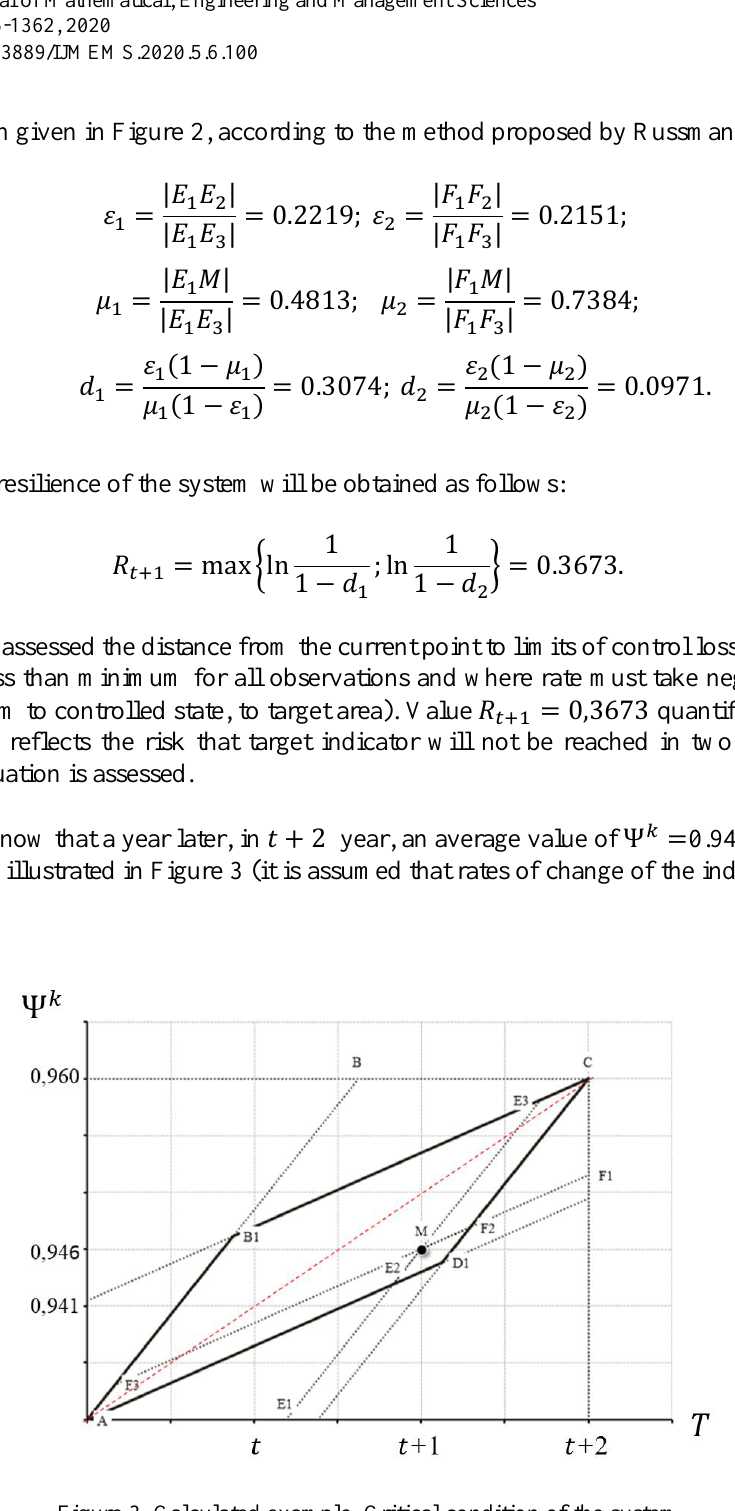
Figure 3. Calculated example. Critical condition of the